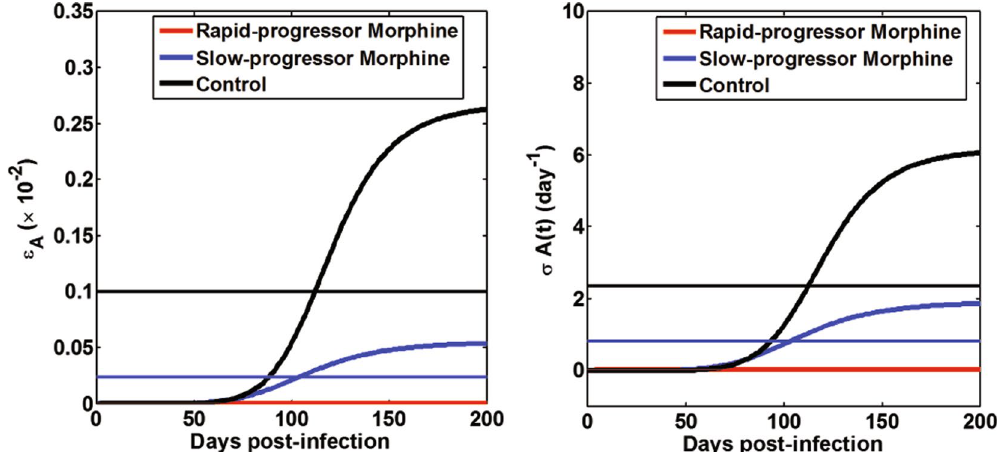
Figure 4. Predicted effects of morphine-altered virus-specific antibody responses on virus neutralization and enhanced virus clearance. The horizontal lines show the mean values of ε A and σ A ( t ) for each group calculated over a period of 200 days post infection